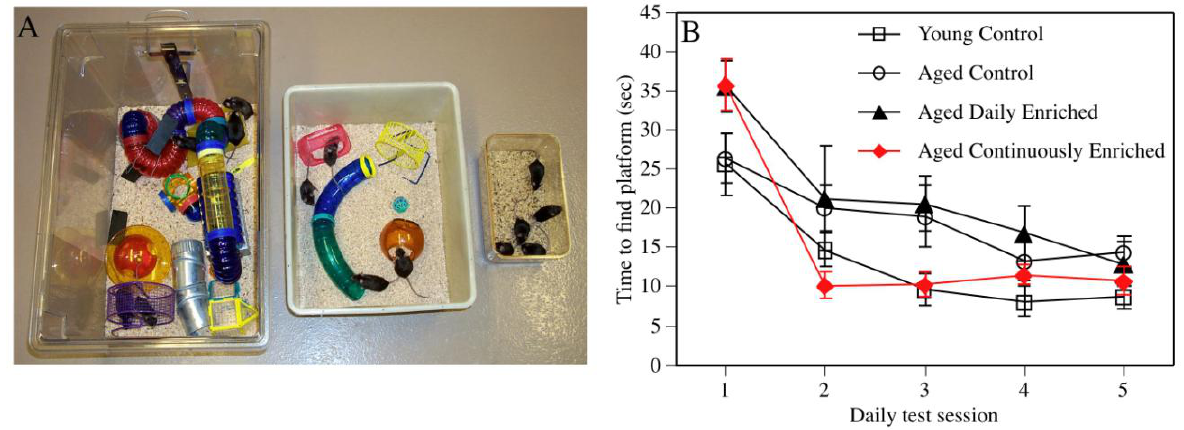
FIGURE 1 . (A) Photograph of the enrichment conditions used by Bennett et al.[30]. Continuous enrichment is shown at left, a bin used in the daily enrichment condition is shown in the middle, and standard housing used for all groups but the aged continuously enriched group is shown at right. (B) Spatial memory in the Morris water maze as illustrated by time to find the hidden escape platform. The aged control group includes mice that received daily handling, as these mice did not differ statistically from nonenriched controls. Only aged continuously enriched mice were unimpaired relative to young controls. Each point represents the mean  standard error of the mean (SEM) of each group during one five-trial test session. Figure modified from Bennett et